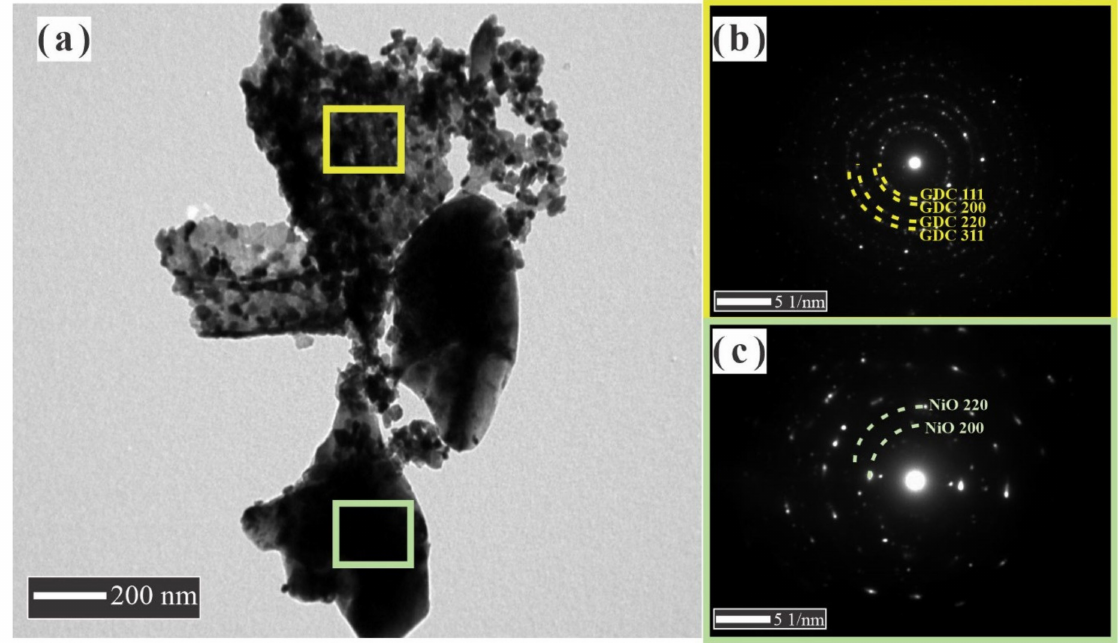
Figure 5. ( a ) TEM image and ( b , c ) spot SAED patterns of NiO-GDC nanocomposites obtained by conventional BM